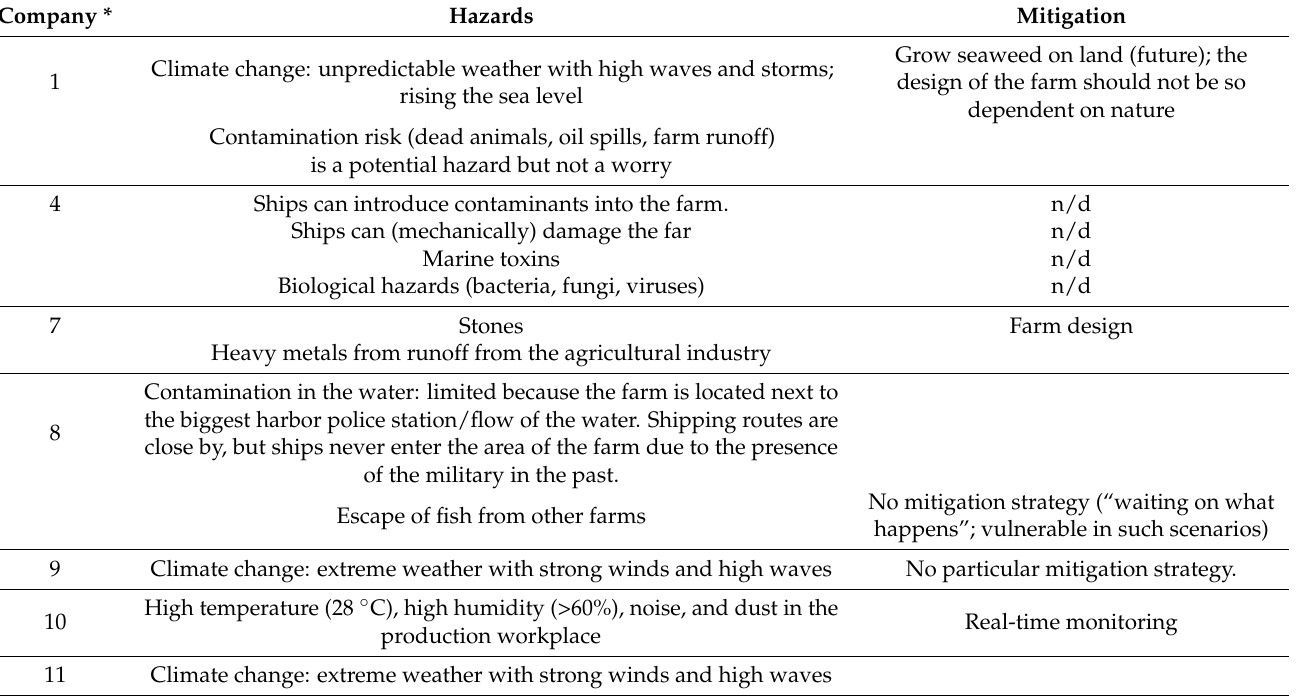
Table 4. Environmental hazards that have an impact on the